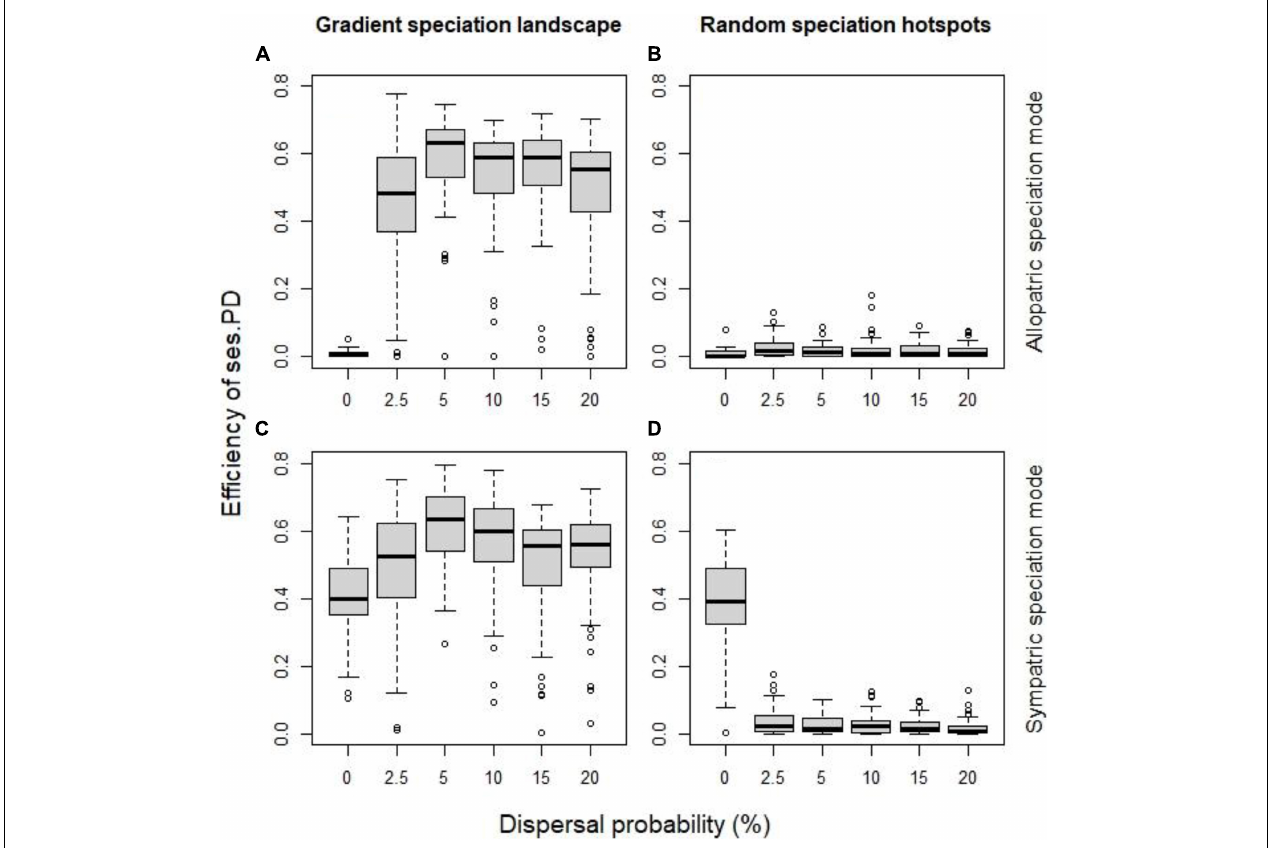
FIGURE 4 | The effect of dispersal probability on the efficiency of the standardized effect size of PD as indicator of speciation history, for allopatric mode of speciation (A,B) and the sympatric mode (C,D) , when speciation hotspots were spatially continuous (A,C) and when they were random (B,D) . All other factor fixed at their default values (initial local richness = 40 species, species pool size = 400 species, probability of local extinction =